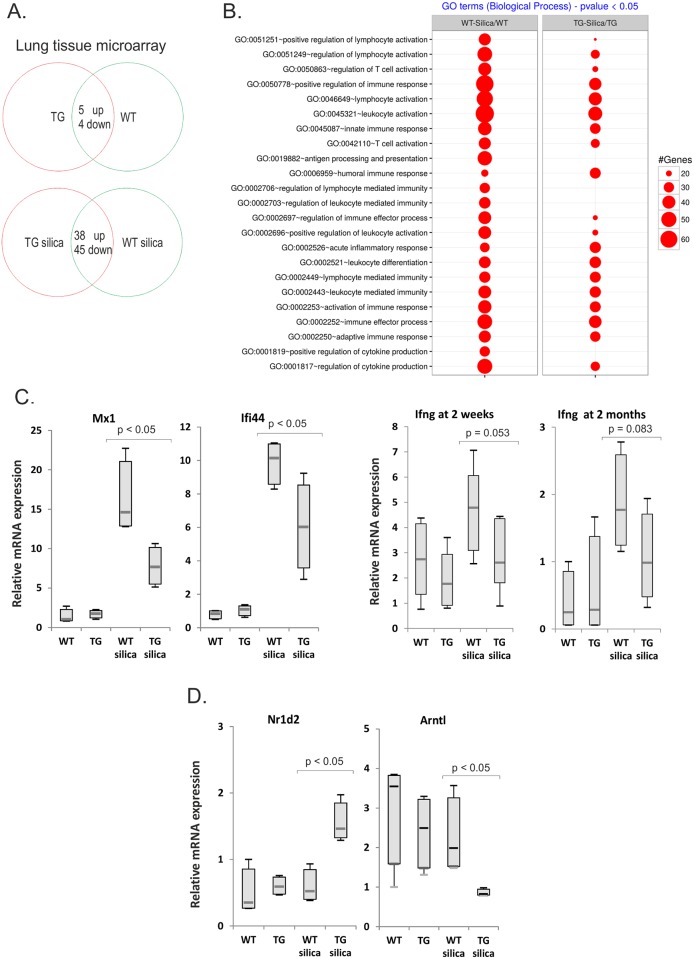
Reduced inflammatory gene response to silica.A. Gene expression microarray was performed using lung tissue mRNA isolated from 6 months old mice (n = 4 in each group). The number of upregulated or downregulated genes are indicated. B. Bubble plots for all immune-related annotations. It compares the most significant Gene Ontology (GO) terms from the “Immune-related Biological Process” ontology found across the different experimental conditions. The same selection strategy was applied for all conditions, which was a significance threshold of 0.05 for the adjusted enrichment p-value, at least five genes from the input list in the enriched category and the whole genome as reference background. C. and D. Quantitative RT-PCR analyses of selected genes identified as differentially expressed in the microarray. The results are presented as box blots. The p values were calculated using the Mann-Whitney U-test (at 2 weeks n = 8; at 2 months n = 4). WT = wild type mice; TG = gremlin-1 transgenic mice.